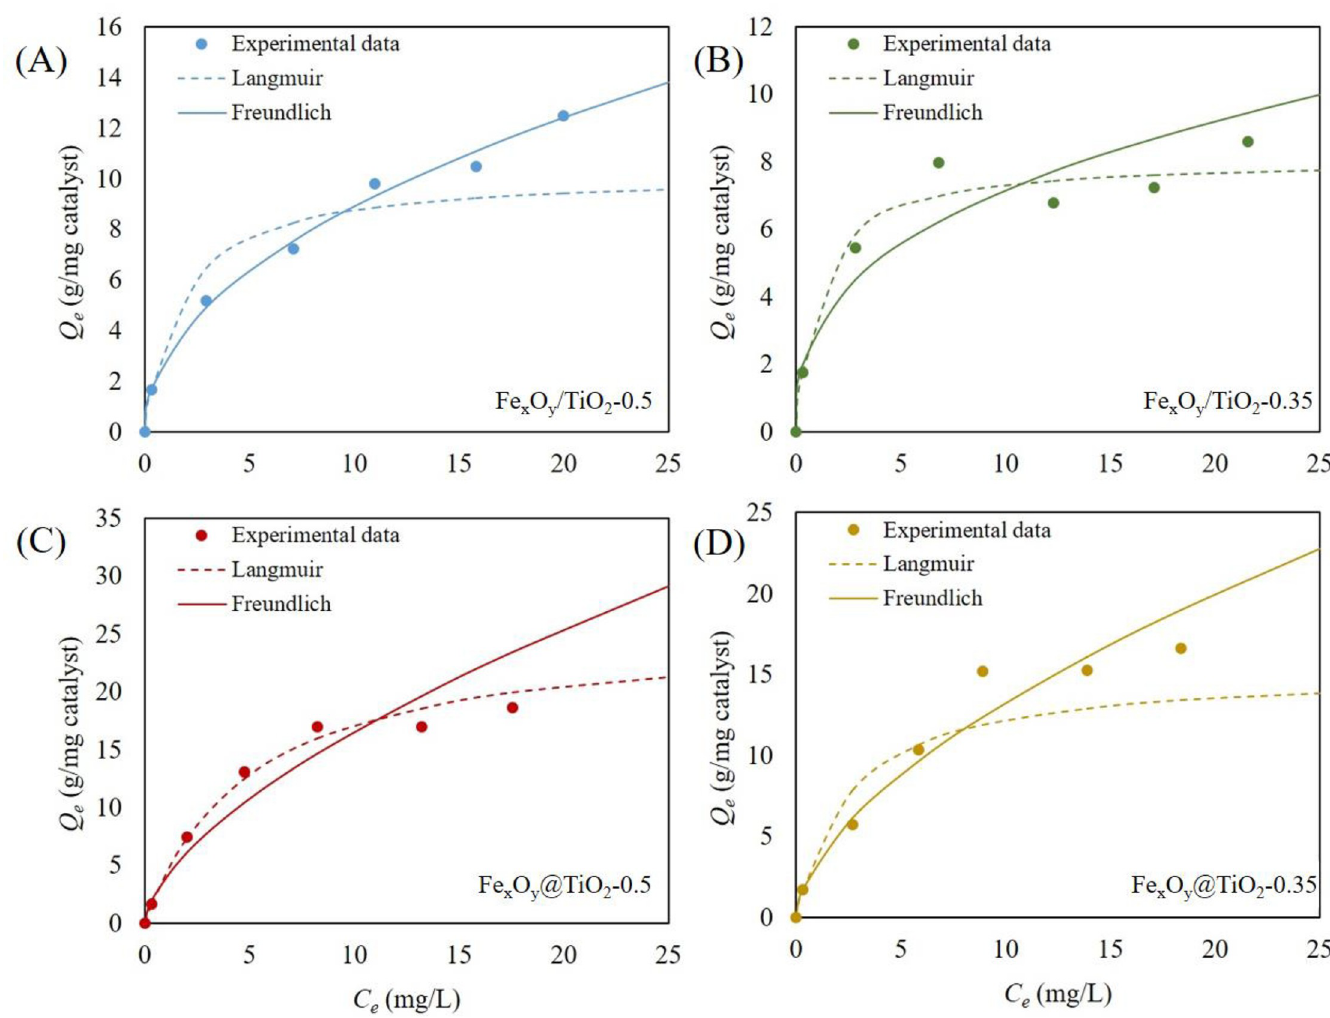
Fig 3. Langmuir (dotted line) and Freundlich (solid line) adsorption isotherms of R6G on the synthesized magnetic-TiO 2 -nanocomposites. (A) Fe x O y /TiO 2 -0.5, (B) Fe